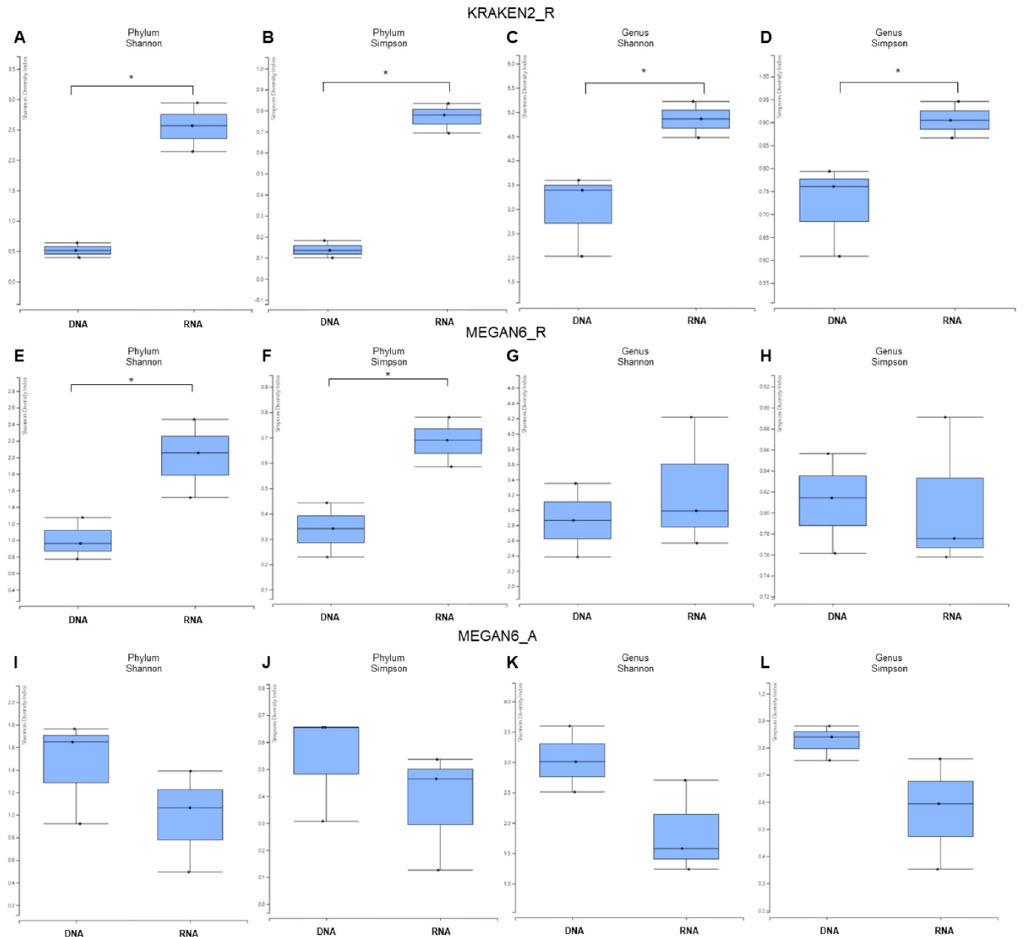
Figure 4. Alpha diversity of identified microbiomes at phylum and genus levels between DNA and RNA libraries. Alpha diversity of microorganisms identified by KRAKEN2_R ( A – D ), MEGAN6_R ( E – H ), and MEGAN6_A ( I – L ) using two different diversity indexes (i.e., Shannon and Simpson). The statistical test carried out was the Wilcoxon rank-sum test (nonparametric). * indicates a p -value less than 0.05.